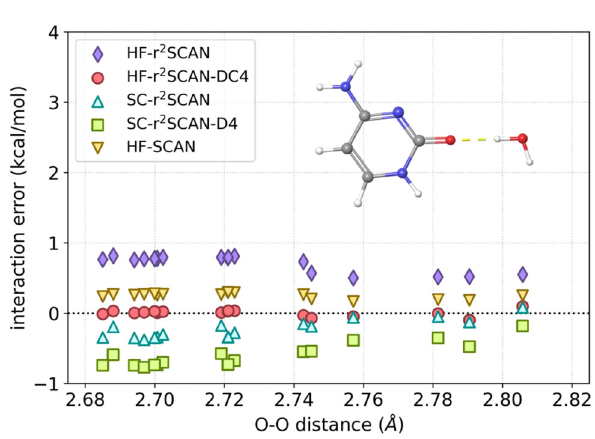
Fig. 4 | Errors in interaction energies of water ⋯ cytosine complexes. Atom color code: C, gray; O, red; N, blue; and H, white. Errors are sorted by the distance between the oxygen atom in cytosine and the oxygen atom in water. Reference interactionenergieshavebeencomputedattheDLPNO-CCSD(T)-F12/AVQZlevelof theory.